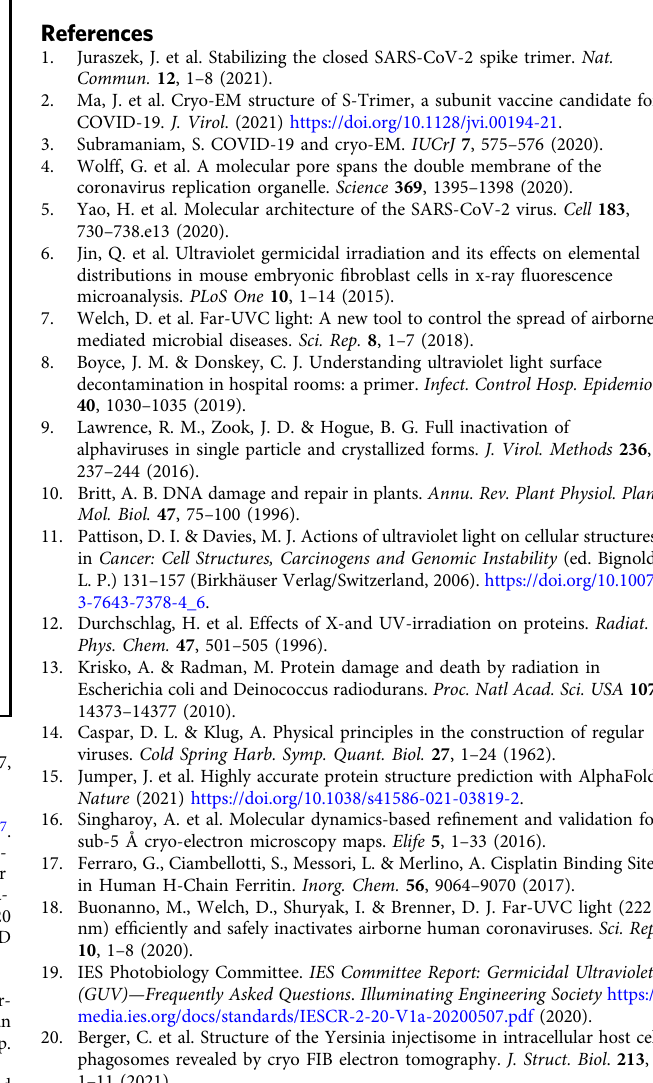
Data availability